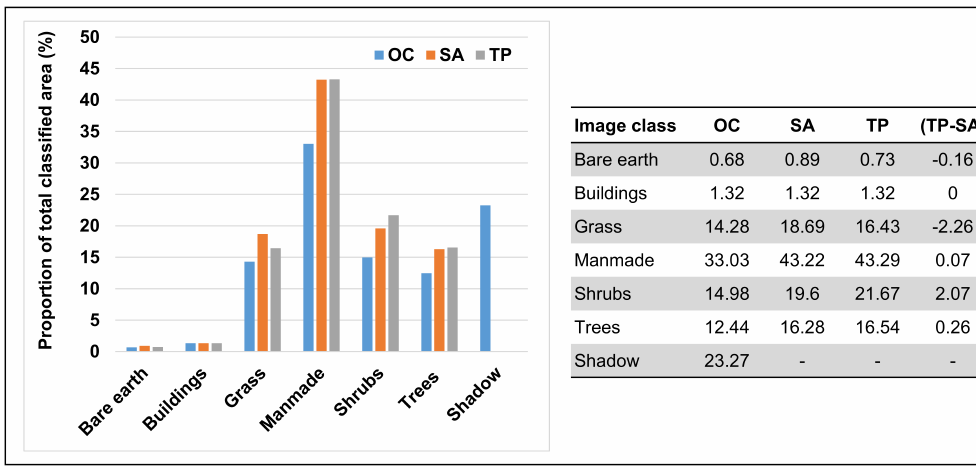
Figure 7. Comparison of total classification class proportions (%) between OC ( blue ), SA ( orange ) and TP ( grey ) methods of class proportion coverage